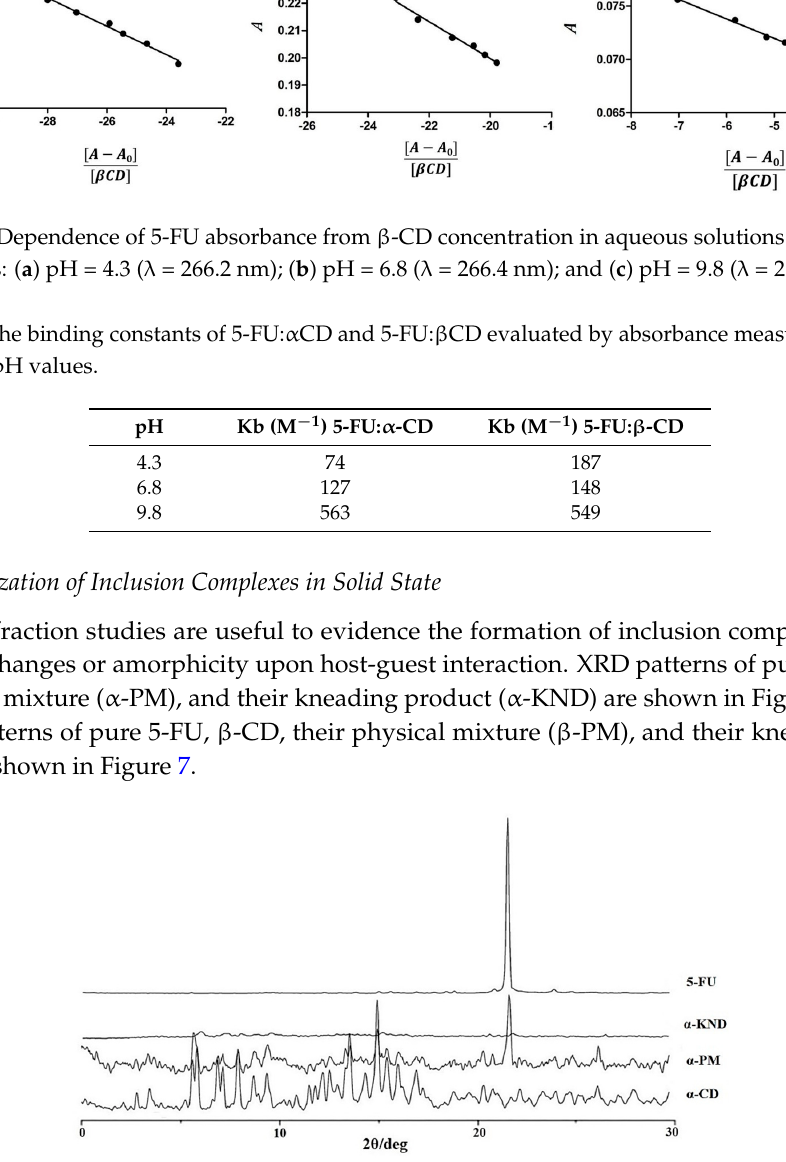
Figure 6. The powder XRD patterns of 5-FU, α -KND, α -PM, and α -CD.